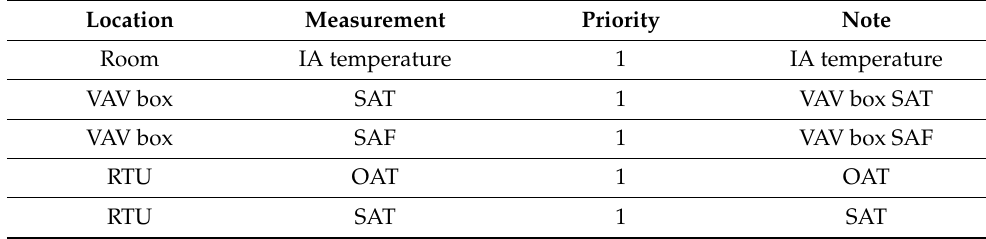
Table 2. Selected sensor